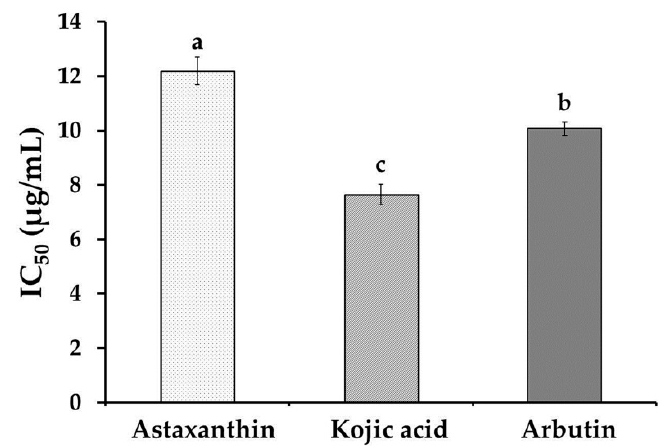
Figure 1. Tyrosinase inhibition activity of astaxanthin extract, kojic acid, and arbutin. Values are expressed as 50% inhibitory concentration (IC 50 ). Letters with different superscripts indicate samples that are significantly different ( p < 0.05) from each other.